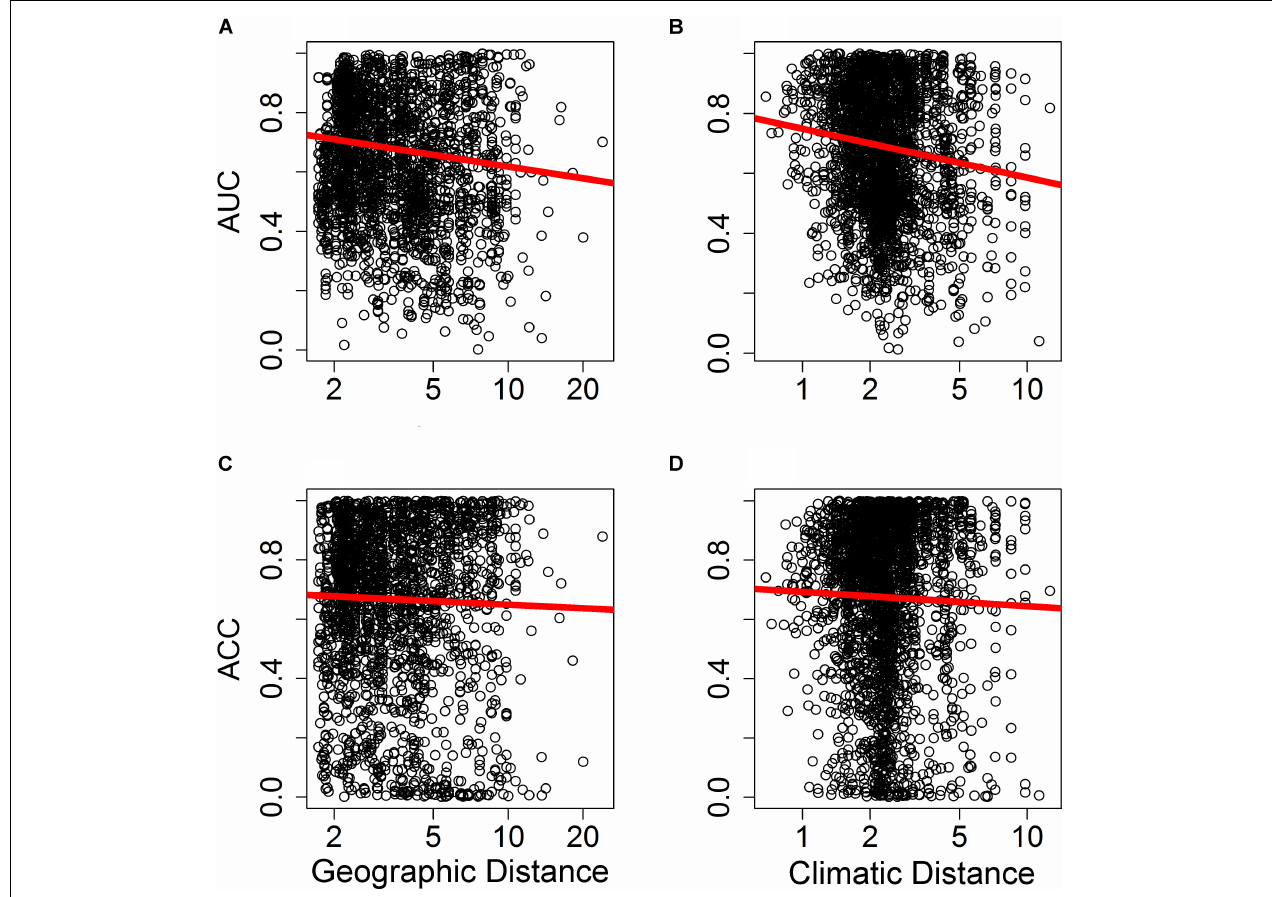
FIGURE 5 | Effect of distance in environmental space on predictive ability of species distribution models (SDM), measured as AUC (A,B) or ACC (C,D) . Each point represents AUC or ACC calculated within a single bin of up to 10,000 holdout points in a novel geographic region binned by distance through either geographic space (A,C) or environmental space (B,D) from the fitting region for one quadrant of a given species and a given SDM algorithm. Distance was measured by first normalizing the distance along each variable axis, then calculating Euclidean distance, and finally dividing by the square root of the number of dimensions (i.e., two for geographic space and 19 for climatic space) to obtain a normalized distance in standard-deviation units. The regression line represents a GAM fit to the